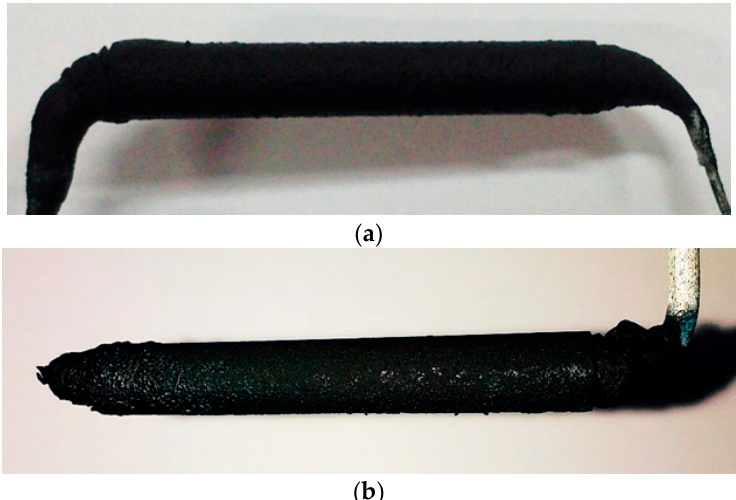
Figure 12. Coating of the diffusion layer: ( a ) the diffusion layer coated manually; ( b ) the diffusion layer coated by self-made device.